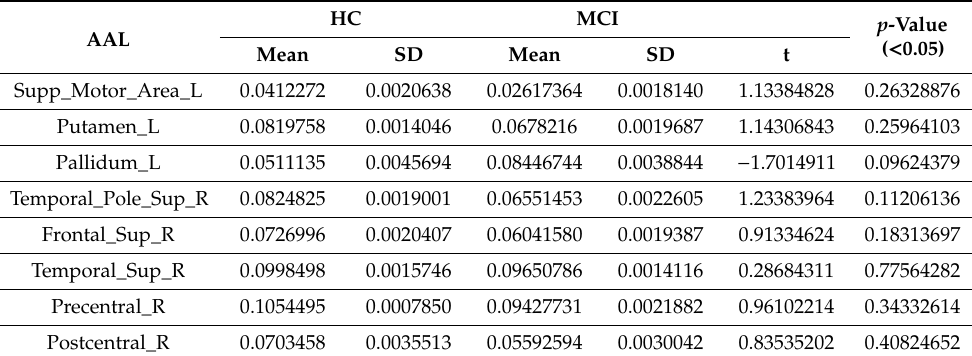
Table 3. Region-of-interest-based clustering coe ffi cient changes between HC and MCI. HC MCI p -Value AAL